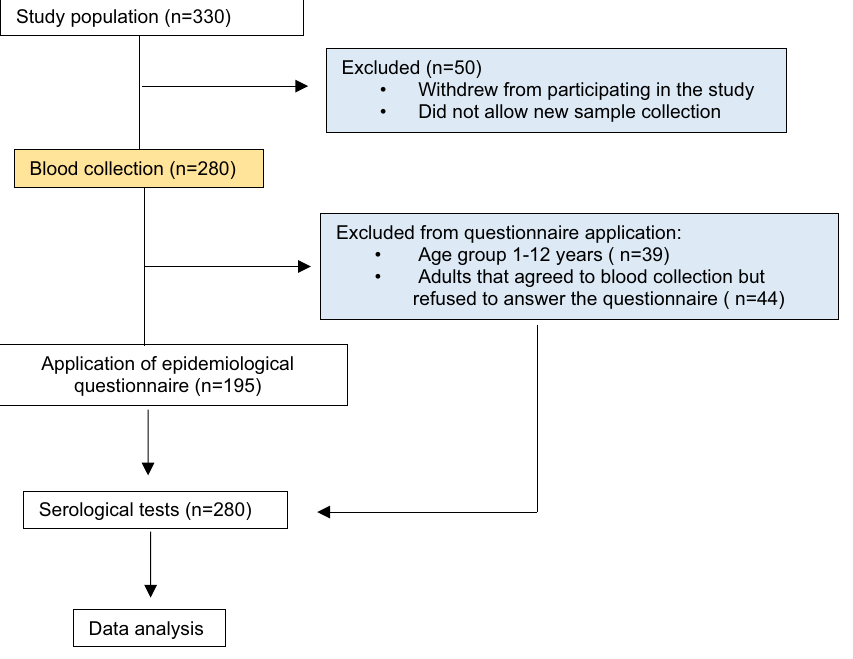
Figure 1. Flow chart shows study design and the number of individuals